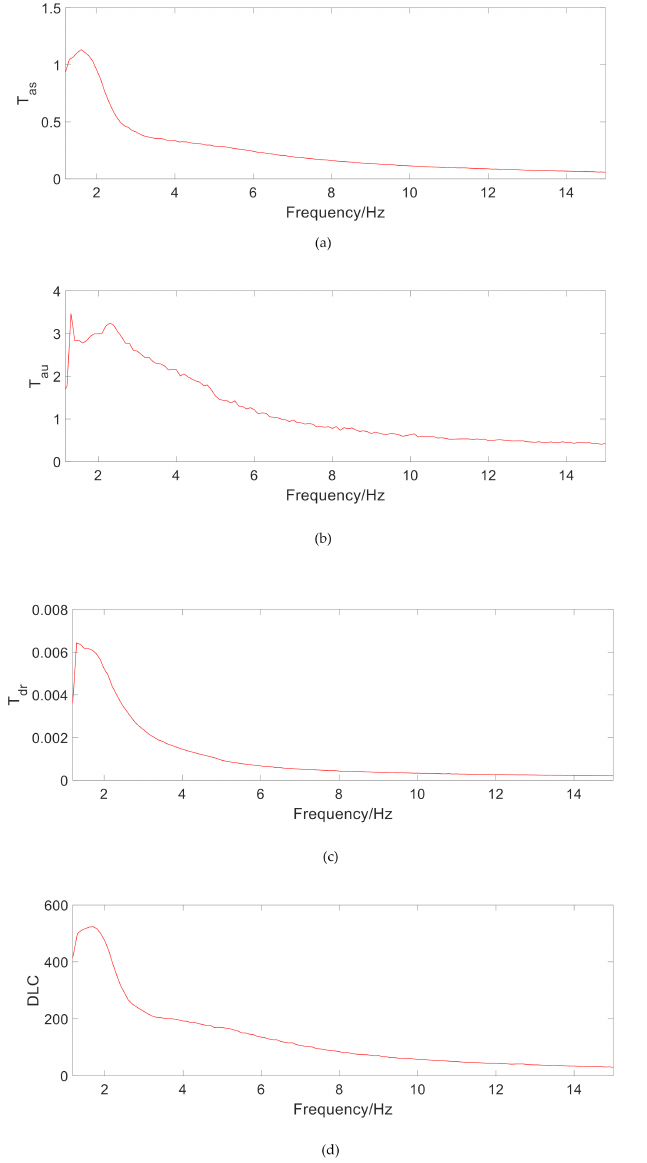
Figure 4. The frequency response of MR regenerative suspension. ( a ) Transmission rate of the sprung mass acceleration, ( b ) Transmission rate of the unsprung mass acceleration, ( c ) Transmission rate of the suspension dynamic travel, ( d ) Dynamic load coe ffi cient of the